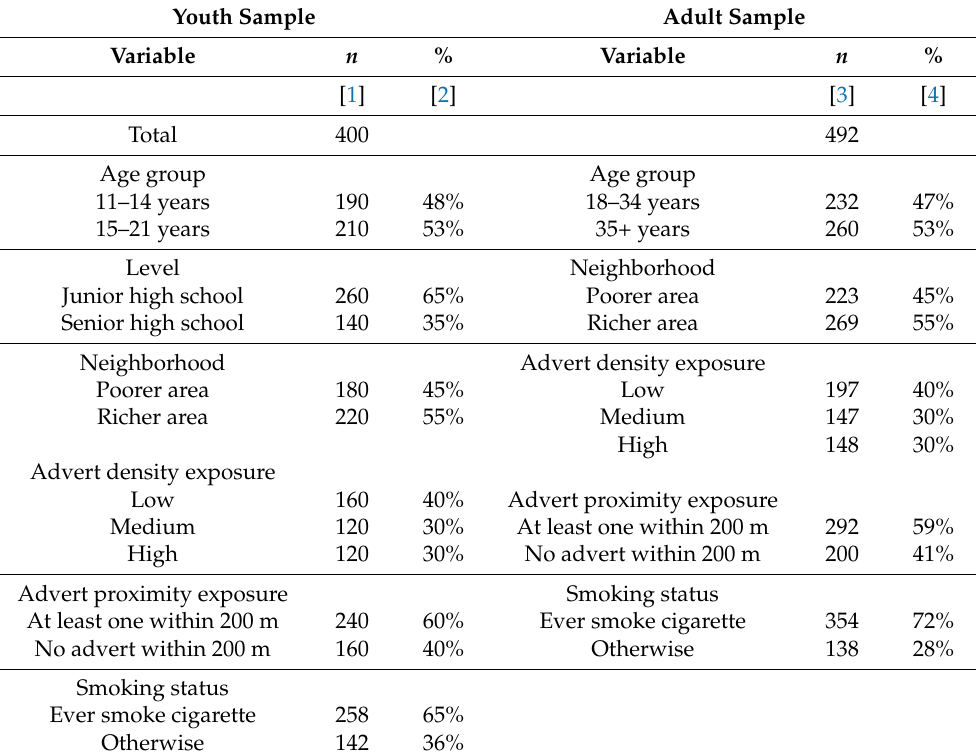
Table 1. Descriptive statistics of youth and adult samples (all males) and outdoor tobacco advertising. Youth Sample Adult Sample Variable n %